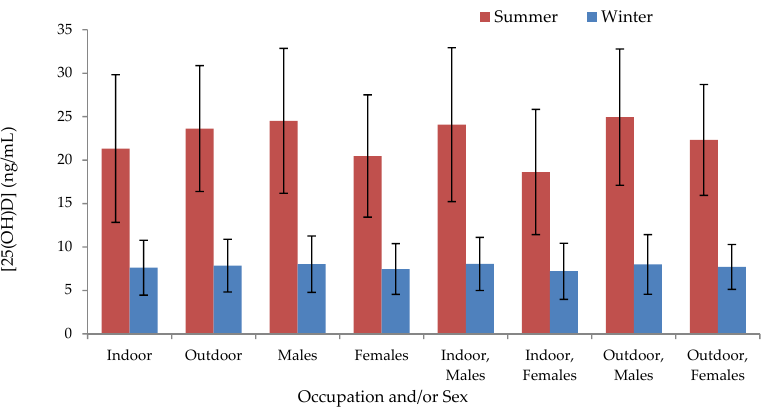
Figure 2. Mean (SD) serum 25(OH)D concentration by season, occupation, and sex. Bars indicate mean measured 25(OH)D concentrations (ng/mL) in summer (red bars) and winter (blue bars) ± SDs, summer n = 318, winter n = 307. Summer: Indoor < Outdoor, Males > Females, Indoor, Females < Indoor, Males = Outdoor, Males = Outdoor, Females, p < 0.05. Winter: Indoor = Outdoor, Males = Females, Indoor, Males = Indoor, Females = Outdoor, Males = Outdoor, Females, p < 0.05.